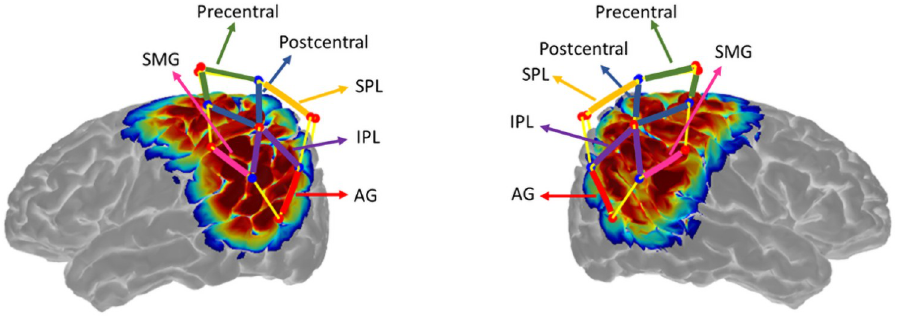
Fig 3. Measurement channels. Six ROIs were derived from the 12 channels located in each hemisphere: pre-central region, post-central region, superior parietal lobule (SPL), inferior parietal lobule (IPL), supra-marginal gyrus (SMG) and angular gyrus